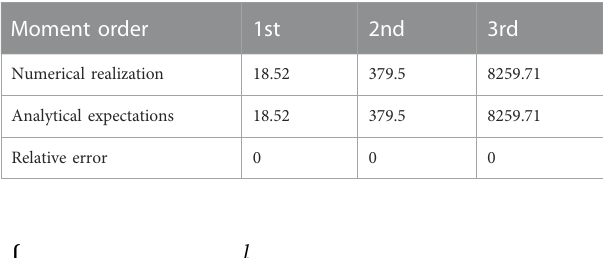
TABLE 3 Moments for a globally coupled